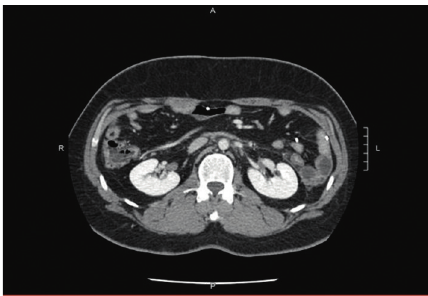
Figure 4: CTimaging of the abdomen and pelvis reveals significant improvement in retroperitoneal mass appearance at 12